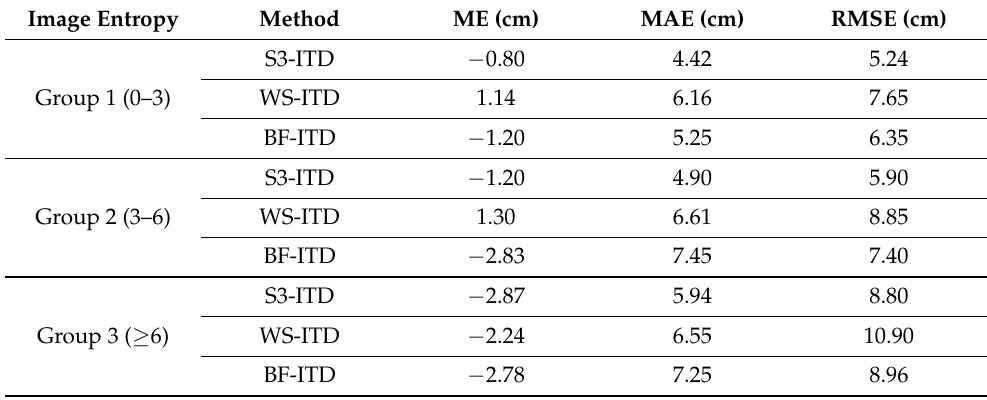
Table 4. The mean error (ME), mean absolute error (MAE), and root mean squared error (RMSE) accuracy of estimated DBH for the proposed and state-of-the-art methods for different image entropy groups. Each entropy group contains the set of trees with similar intracrown pixel variance. Image Entropy